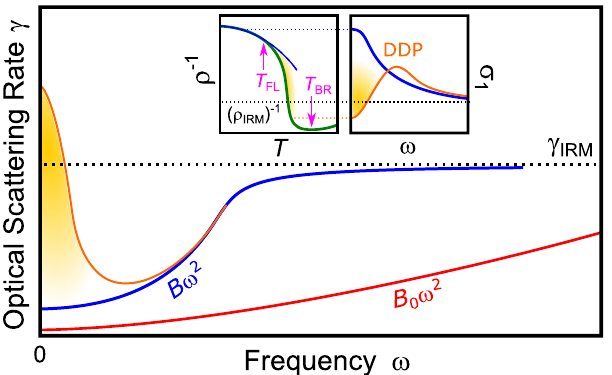
Fig. 1 Scattering rate of correlated metals. In a Fermi liquid γ ( T , ω ) scales with T 2 and ω 2 due to the increase in scattering phase space (Eq. (1)).